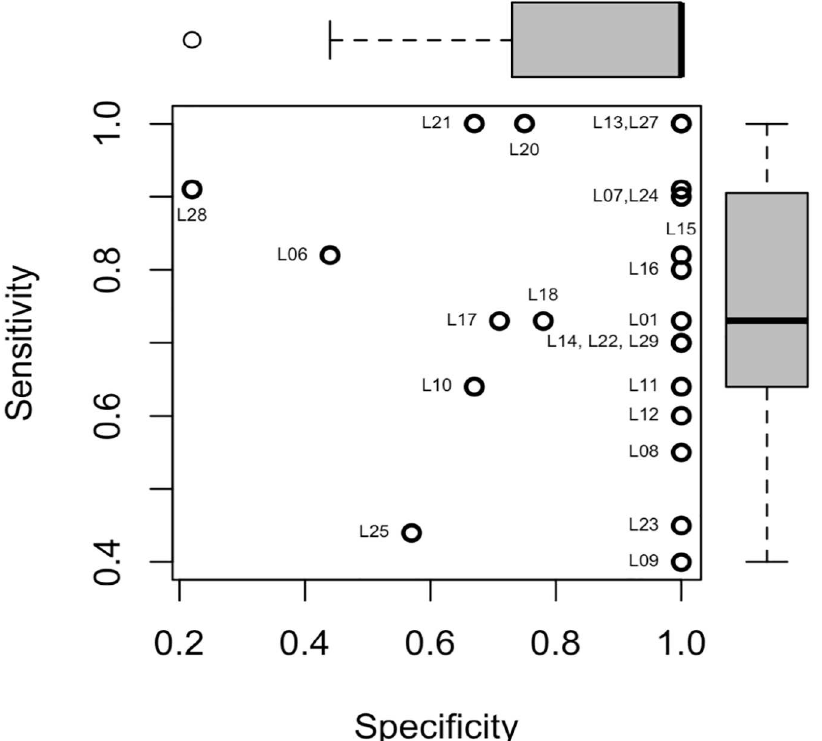
Fig 1. Scatterplot of Sensitivity by Specificity. The sensitivity (y-axis), or the true positive rates and the specificity (x-axis), or the true negative rates, for each laboratoryare shown with an open circle. A laboratory correctly identifying all samples would be found in the upper right